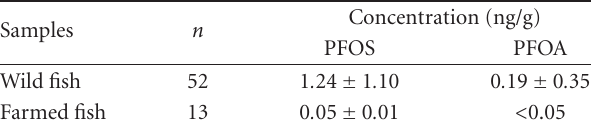
Table 3: Concentration levels (mean ± standard deviation) of PFOS and PFOA in wild and farmed fish